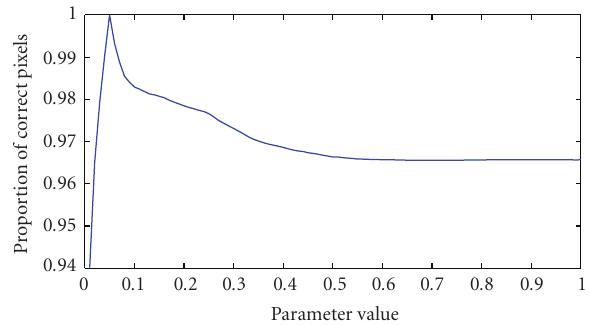
Figure 15: Proportion of correct pixels for di ff erent values of λ . Correctness was measured with respect to a reference depth map with good quality.